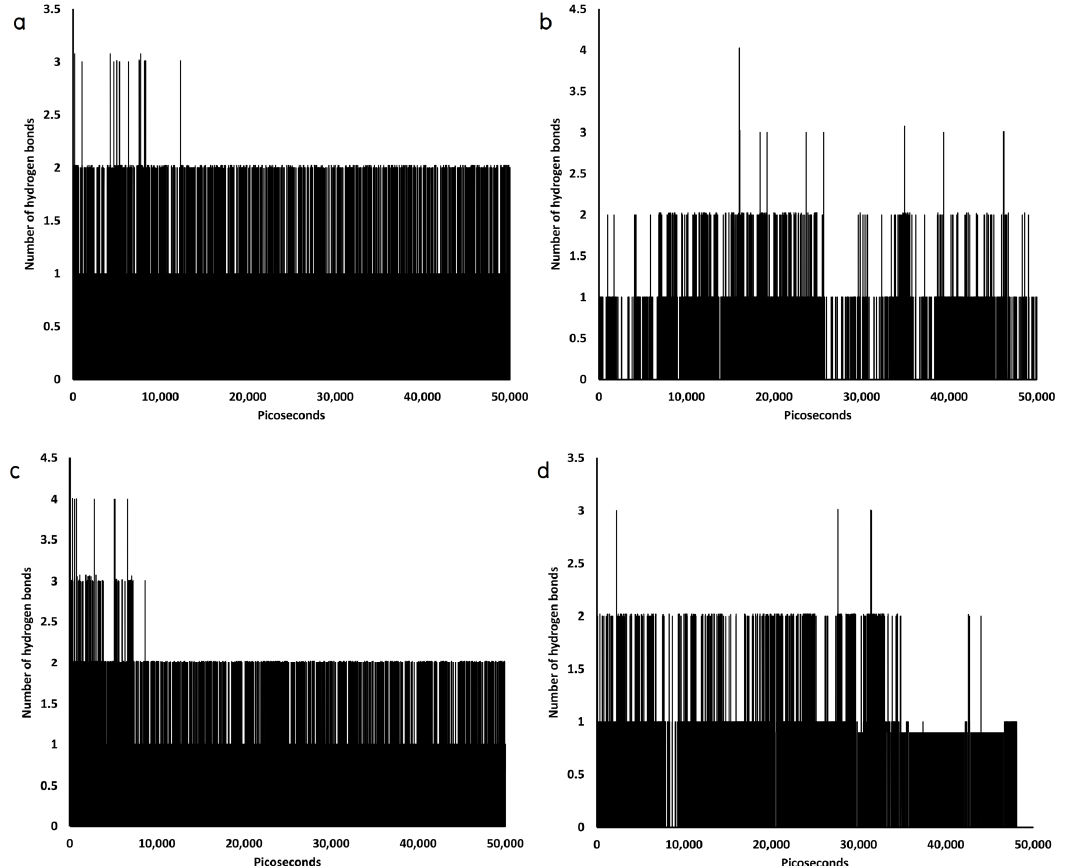
Figure 6. Evaluation of hydrogen bond interaction between the small collagen peptides and the POPC membrane shows the